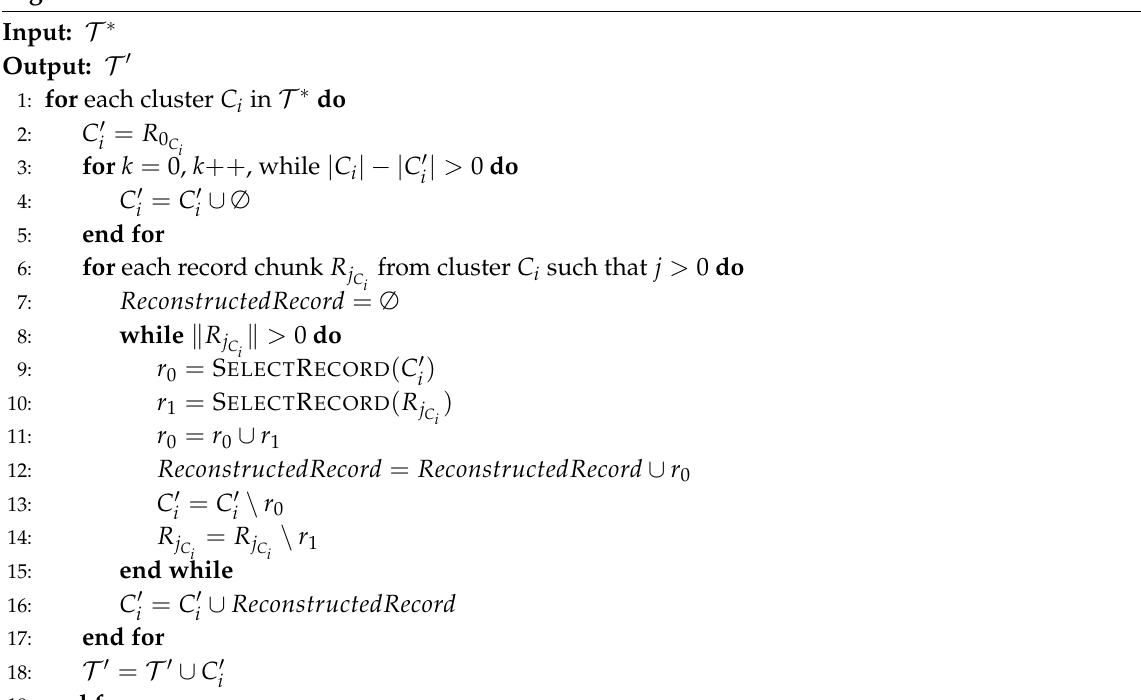
Algorithm 5 Probabilistic wheel